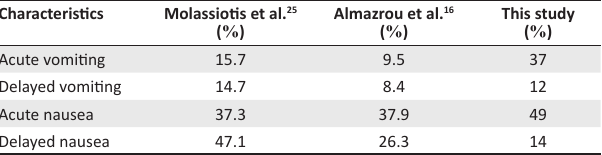
TABLE 4: Comparison of the CINV frequency in this study with previous studies.